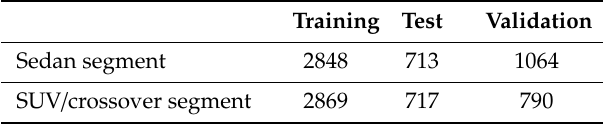
Table 6. Sample sizes (vehicle model by year) for